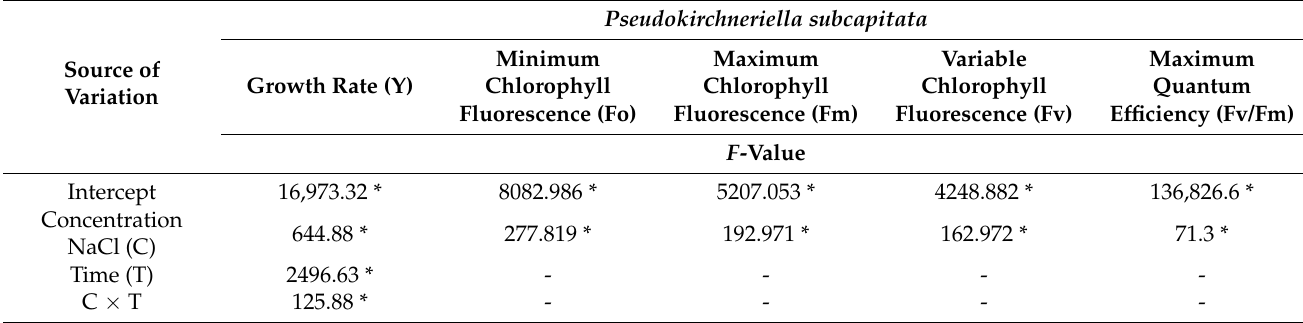
Table 1. Analysis of variance (ANOVA) for morphological and biochemical features of algae Pseudokirchneriella subcapitata exposed to sodium chloride (NaCl).